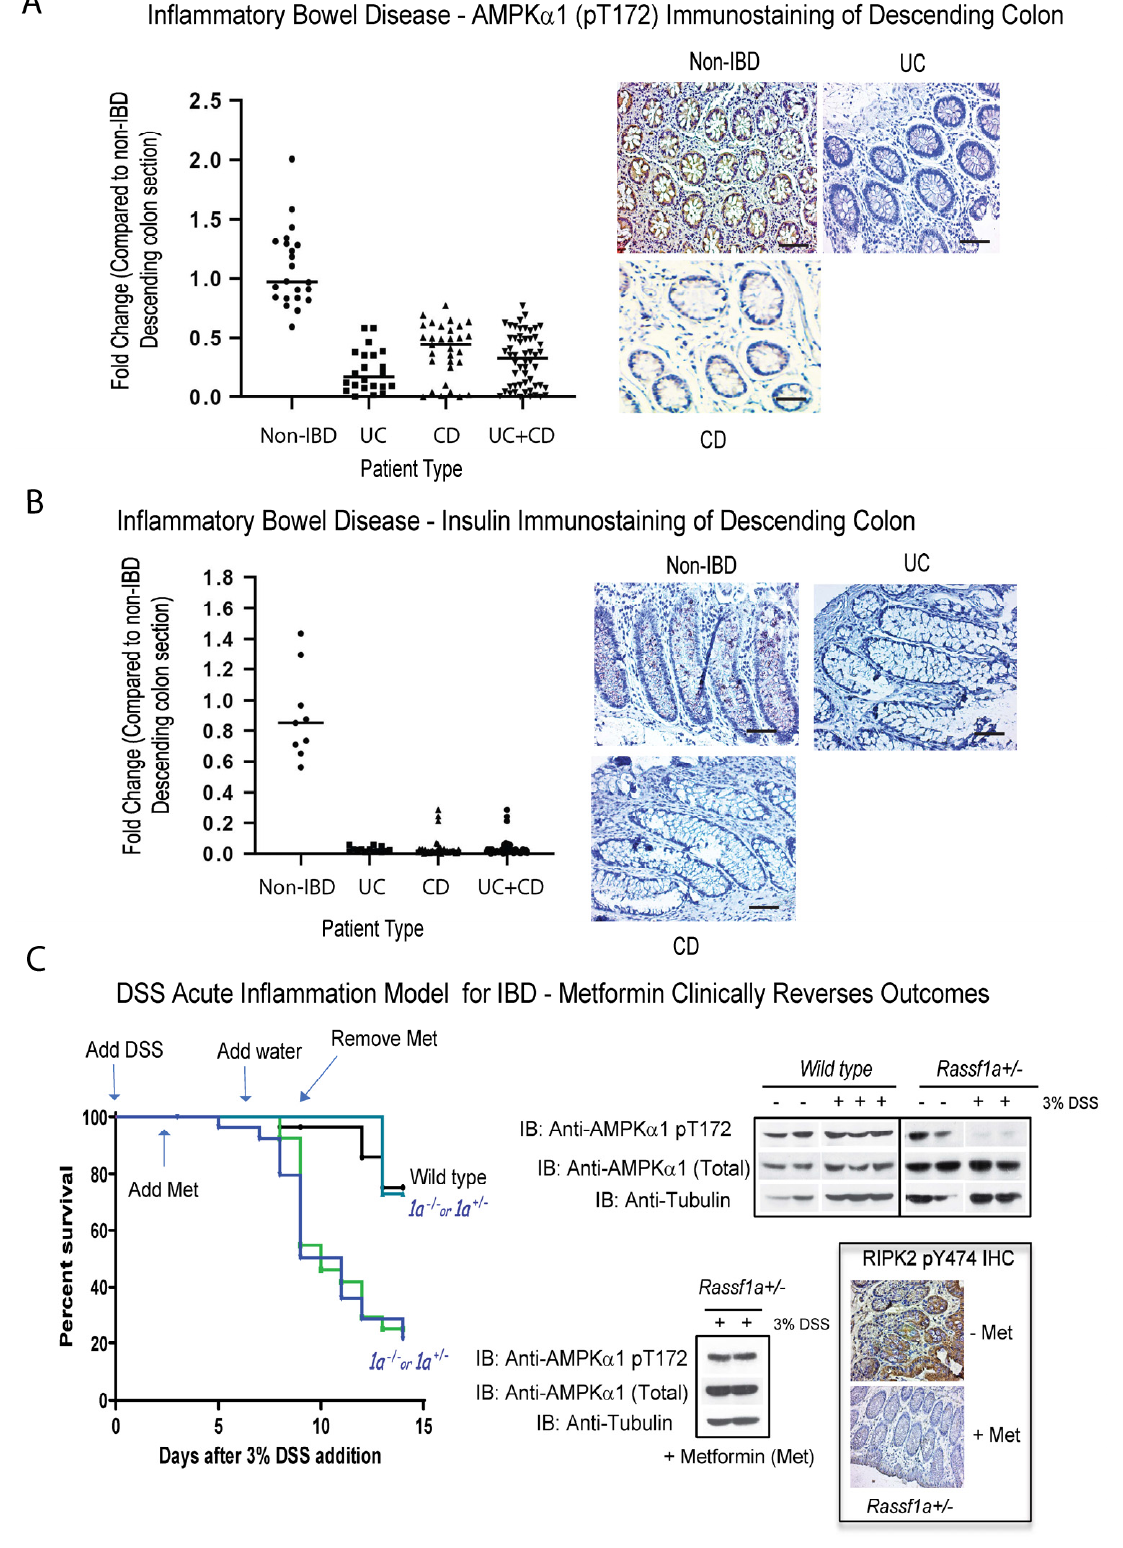
Figure 3. Loss of metabolic markers in IBD and a metabolism-directed therapeutic intervention in an IBD mouse model. Immunohistochemical staining for ( A ) (AMPK α 1) pT172 and ( B ) insulin in descending colon sections of IBD patients, reveal loss of activation of (AMPK α 1) and tissue expres- sion of insulin. Left panel, summary of fold change in IHC staining of tissue sections; right panel, representative sections for each patient category. ( C ) DSS-induced in fl ammation injury model of acute in fl ammation was carried out in the DSS-susceptible model, Rassf1a +/ − ( 1a +/ − ). Metformin was given in the drinking water at 2 g/L (human equivalent dose [HED] = 500 mg/day) from day 3 to day 9 (during peak of in fl ammation injury). Mice were monitored for piloerection, bloatednesss, tremors, lack of movement, and rectal bleeding. Left panel, Kaplan–Meier curve with n = 13 (DSS/metformin treated) and n = 28 (DSS treated) animals were used for all conditions and p -value between wild type and Rassf1a − / − . was <0.005. Right panel, immunoblot of descending colon lysates from experiment in the left panel, with the indicated antibodies, as well as representative colon sec- tions stained for active RIPK2 (using the pY 474 RIPK2 antibody) upon metformin treatment. For ( A ), p value < 0.001 for di ff erence between UC/CD/UC+CD vs. non-IBD (n = 30 for non-IBD and 26